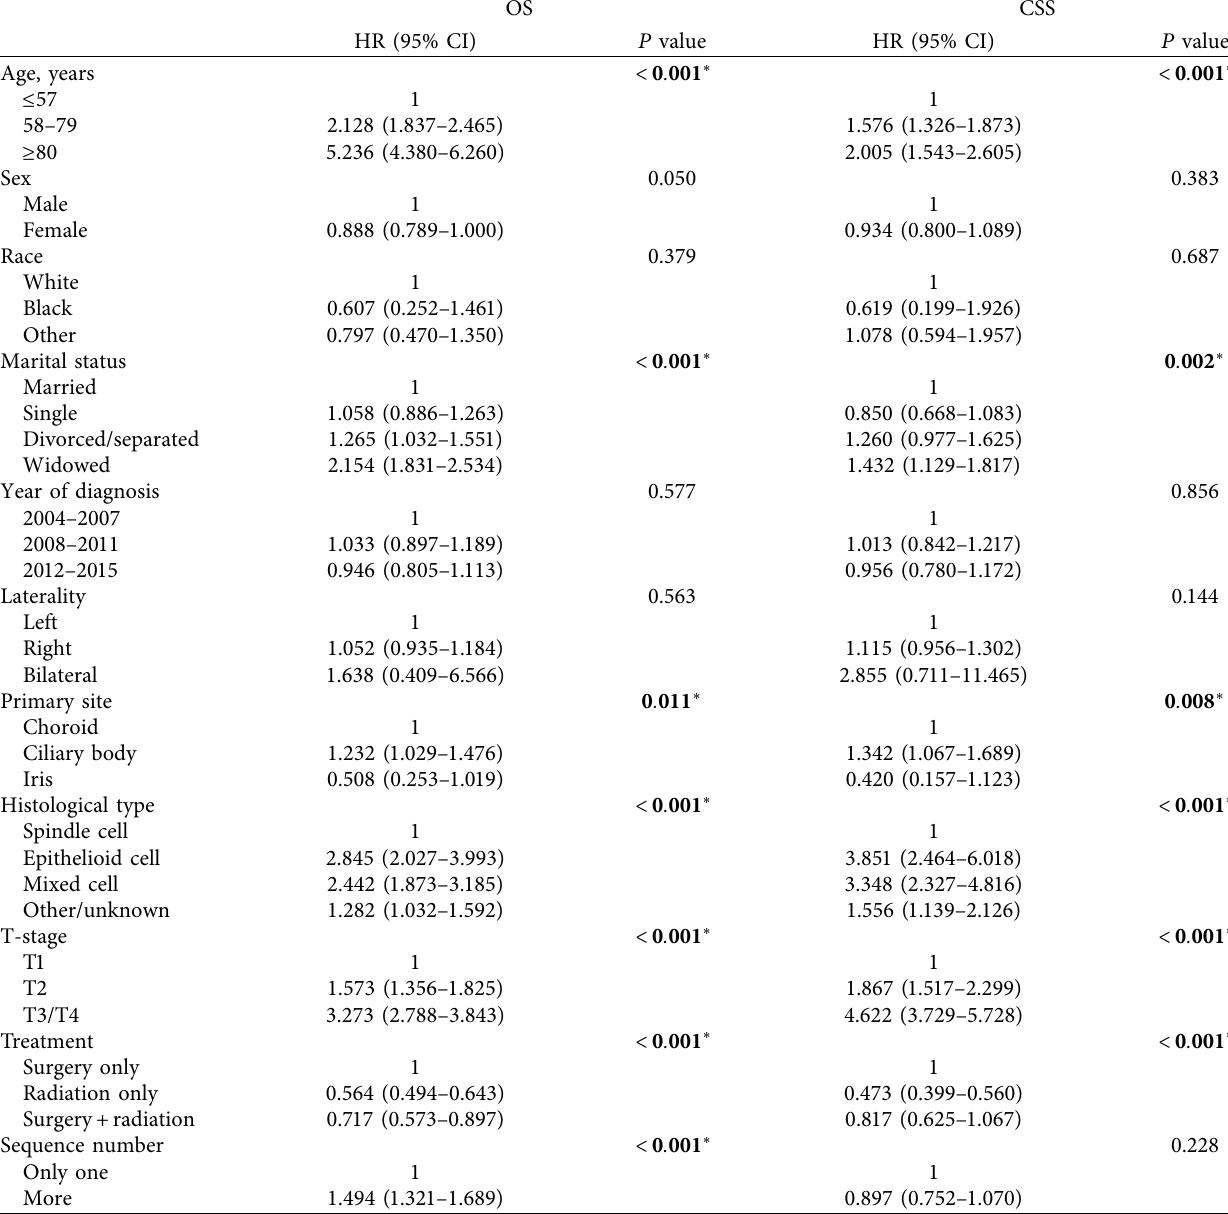
Table 2: Univariate Cox regression analysis of OS and CSS in the training